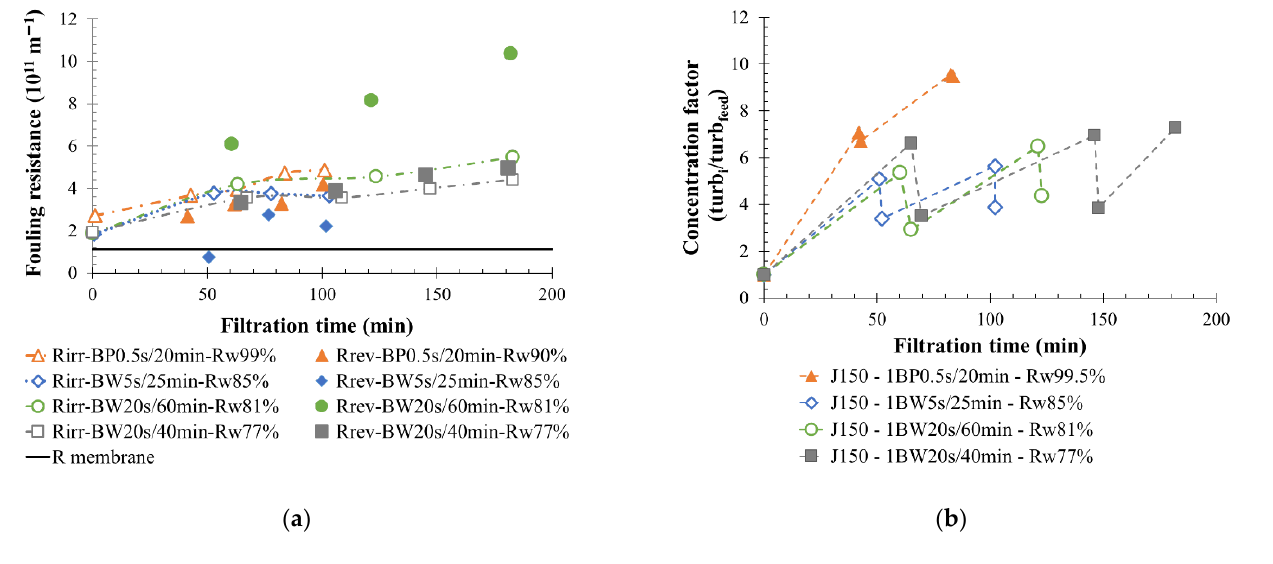
Figure 14. Influence of backflush mode (BP-BW) on membrane filtration behavior by variation fouling resistance ( a ), and the turbidity concentration ration ( b ) throughout the time for a permeate flux of 150 L h −1 m −2 and a 1 BP 0.5 s/20 min (triangle); 1 BW 20 s/40 min (squared); 1 BW 20 s/60 min (round); 1 BW 5 s/25 min (diamond). T = 20 °C, feedwater from APL -SINGAPURA-AE; SiC membrane 0.33 m 2 . Jxx is permeate flux at the xx value in L h − 1 m − 2 ; 1BW (or BP) yy s/zz min where yy is the duration and zz the interval of filtration between two BW (or BP); and R w is the total recovery rate applied to the unit; R irr is irreversible resistance; R rev is reversible resistance and R membrane is the membrane resistance. Table 2. Turbidity range in concentrate side and permeate side during experiments. Range of Loop Turbidity Value Average Permeate Turbidity Value Throughout the Filtration Experiment (NTU)